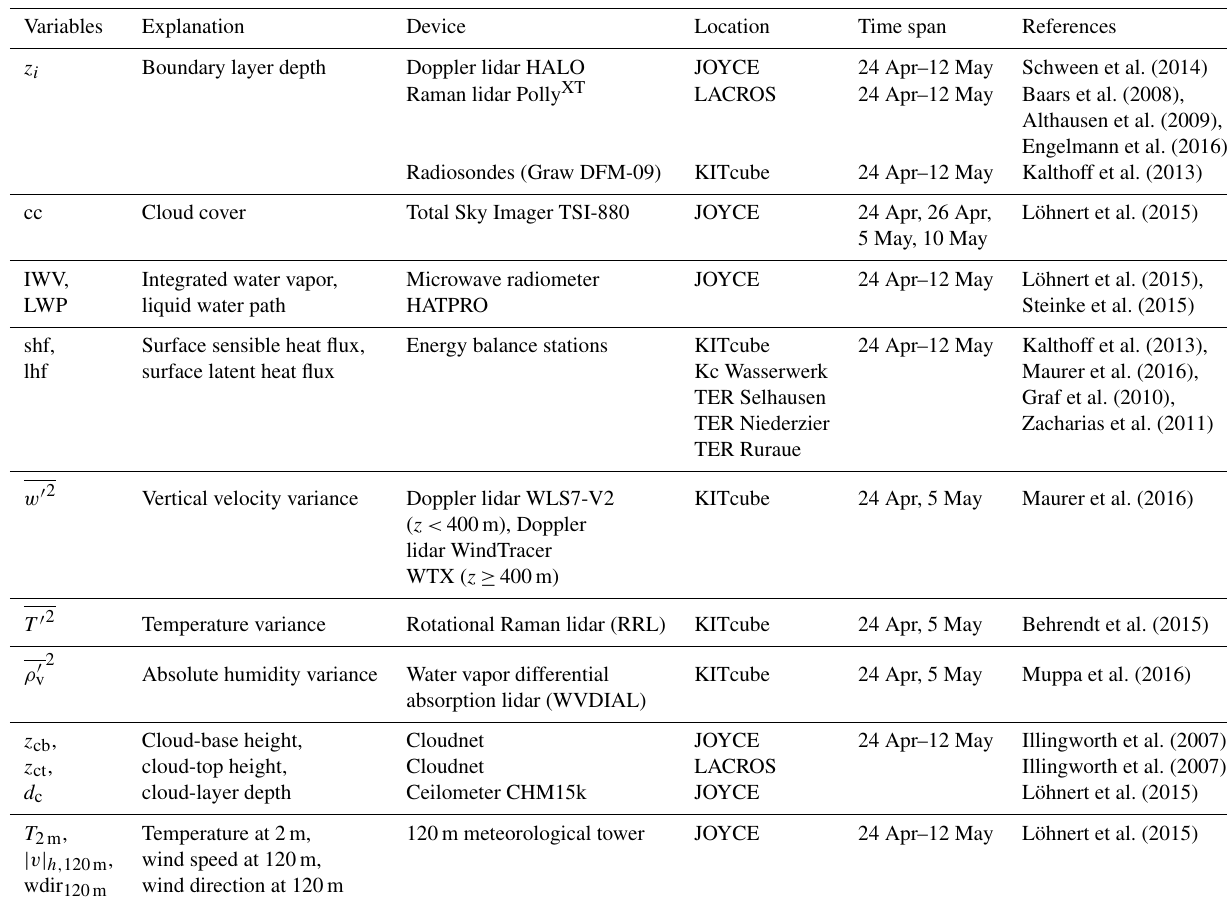
Table 1. Overview of the HOPE measurements used in this study.